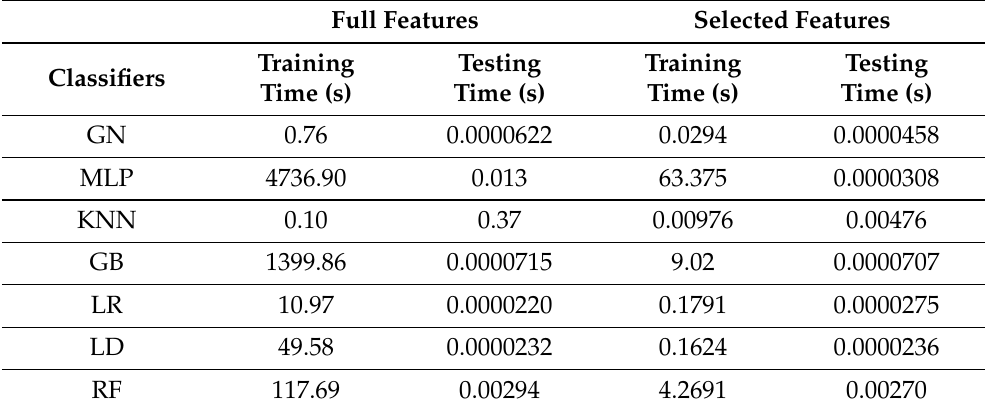
Table 1. Training and average testing time of all chosen classifiers for malware detection